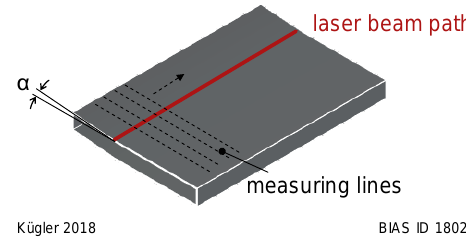
Figure 3. The distortion measurements after laser processing.